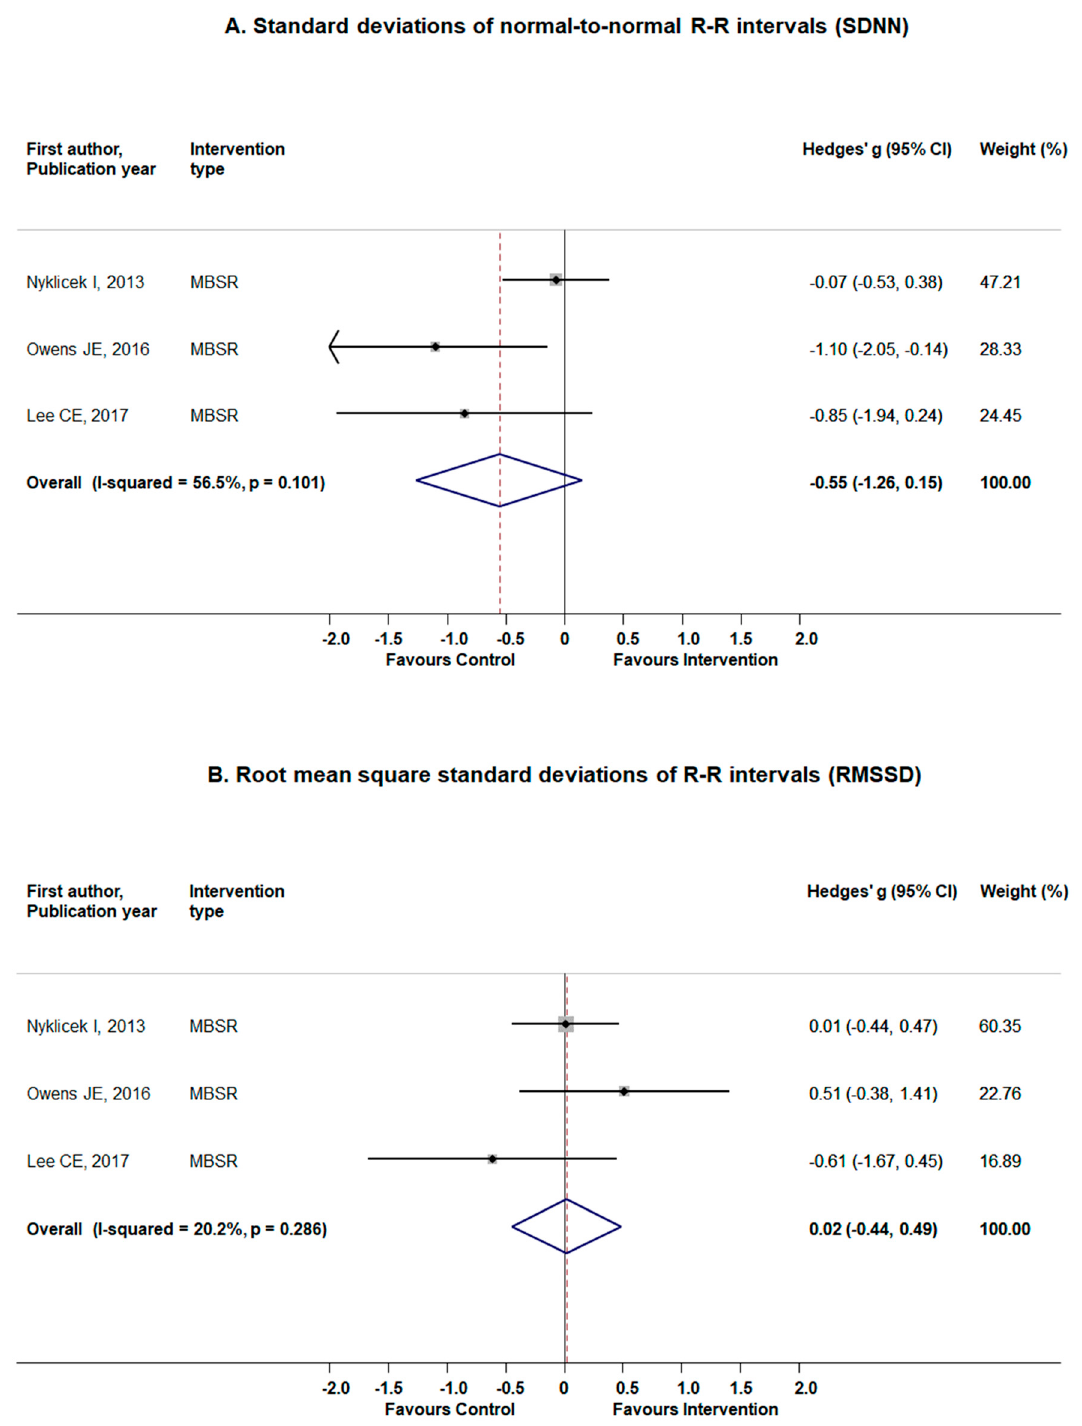
Figure 5. The e ff ects of standardized mindfulness-based interventions on time domain heart rate variability (HRV) parameters: standard deviations of normal-to-normal R-R intervals (SDNN) (panel A ) and root mean square standard deviations of R-R intervals (RMSSD) (panel B ) . Squares indicate standardized di ff erence in means (Hedges’ g) and lines represent 95% confidence intervals (CI); the size of the box represents the weight of each